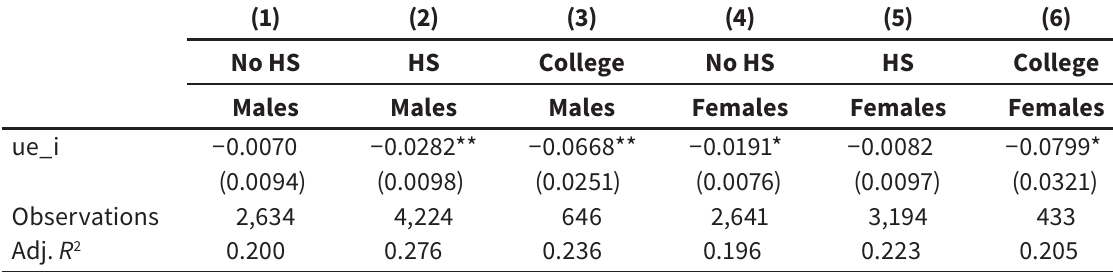
Table 8 Heterogeneity within log wage